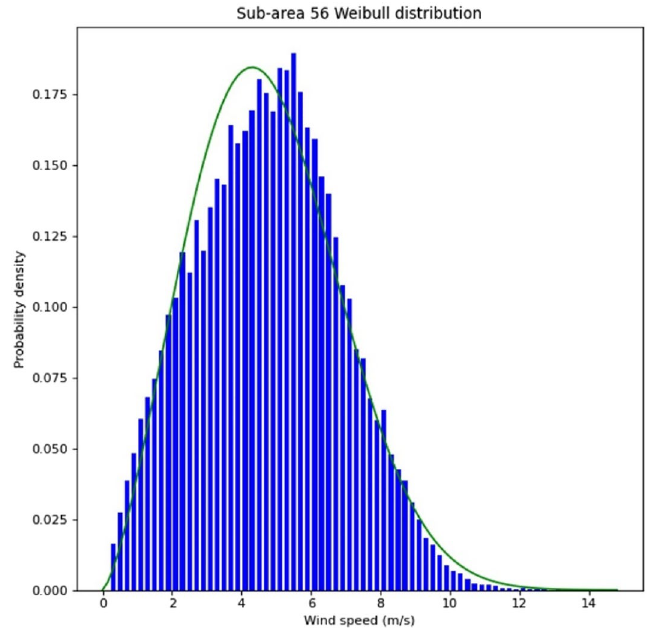
Fig. 17 Weibull distribution of sub-area 56